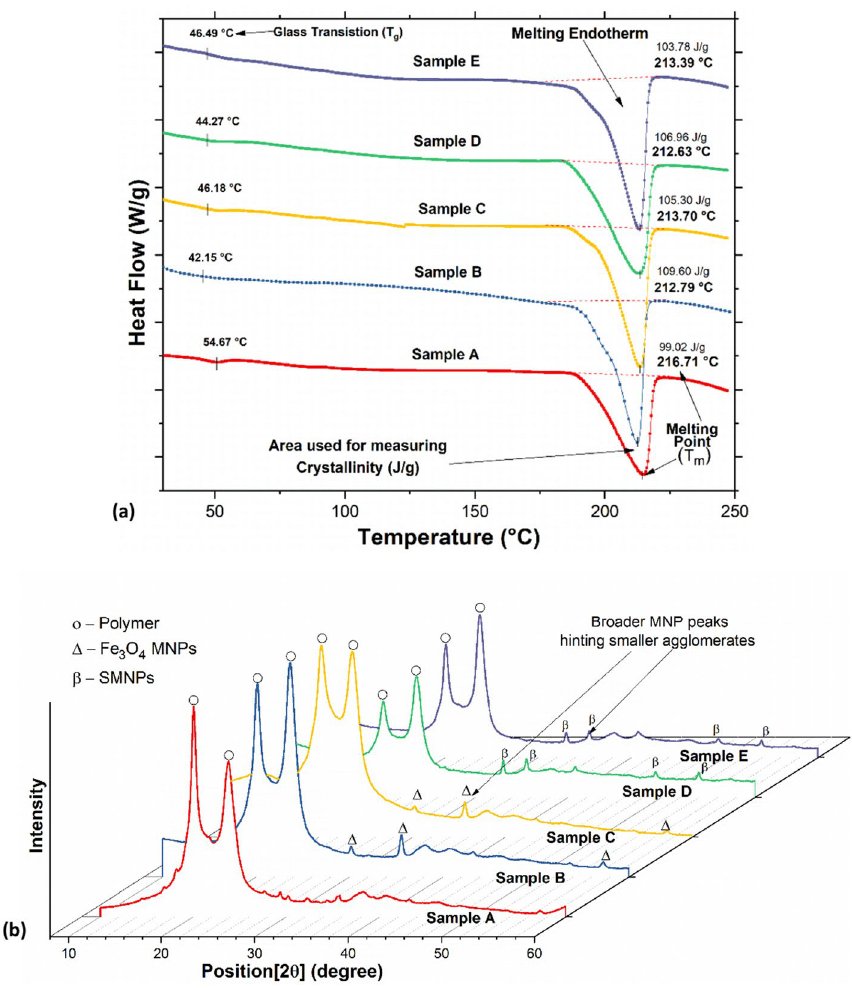
Figure 3. ( a ) DSC curves of all the prepared SHMNP composite samples A to E, showing the glass transition temperatures and melting points and ( b ) XRD patterns of all the prepared SHMNP composite samples A to